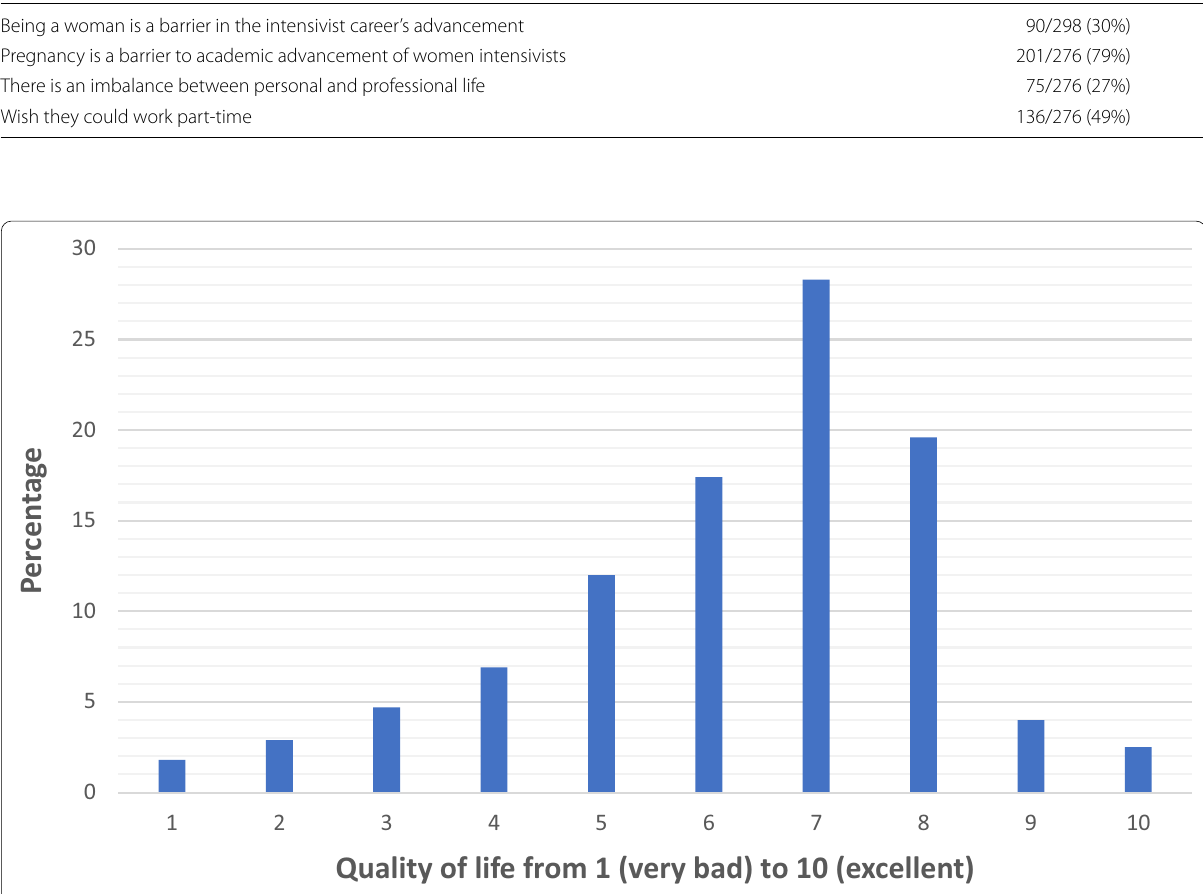
Fig. 1 Represents the distribution of the respondents as a function of their perceived quality of life at work, on a scale varying from 1 (very bad quality of life) to 10 (excellent quality of life)) ( N =